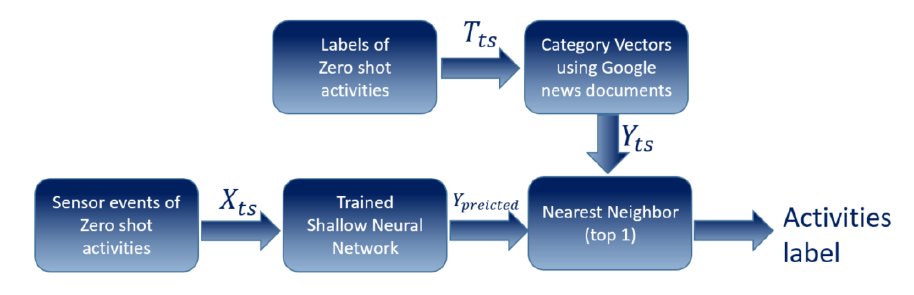
Figure 3. Test phase, where T ts are the zero-shot class labels, X ts are the sensor readings of zero-shot activities, and Y ts is its corresponding L-dimensional semantic representation vector of the zero-shot class labels.